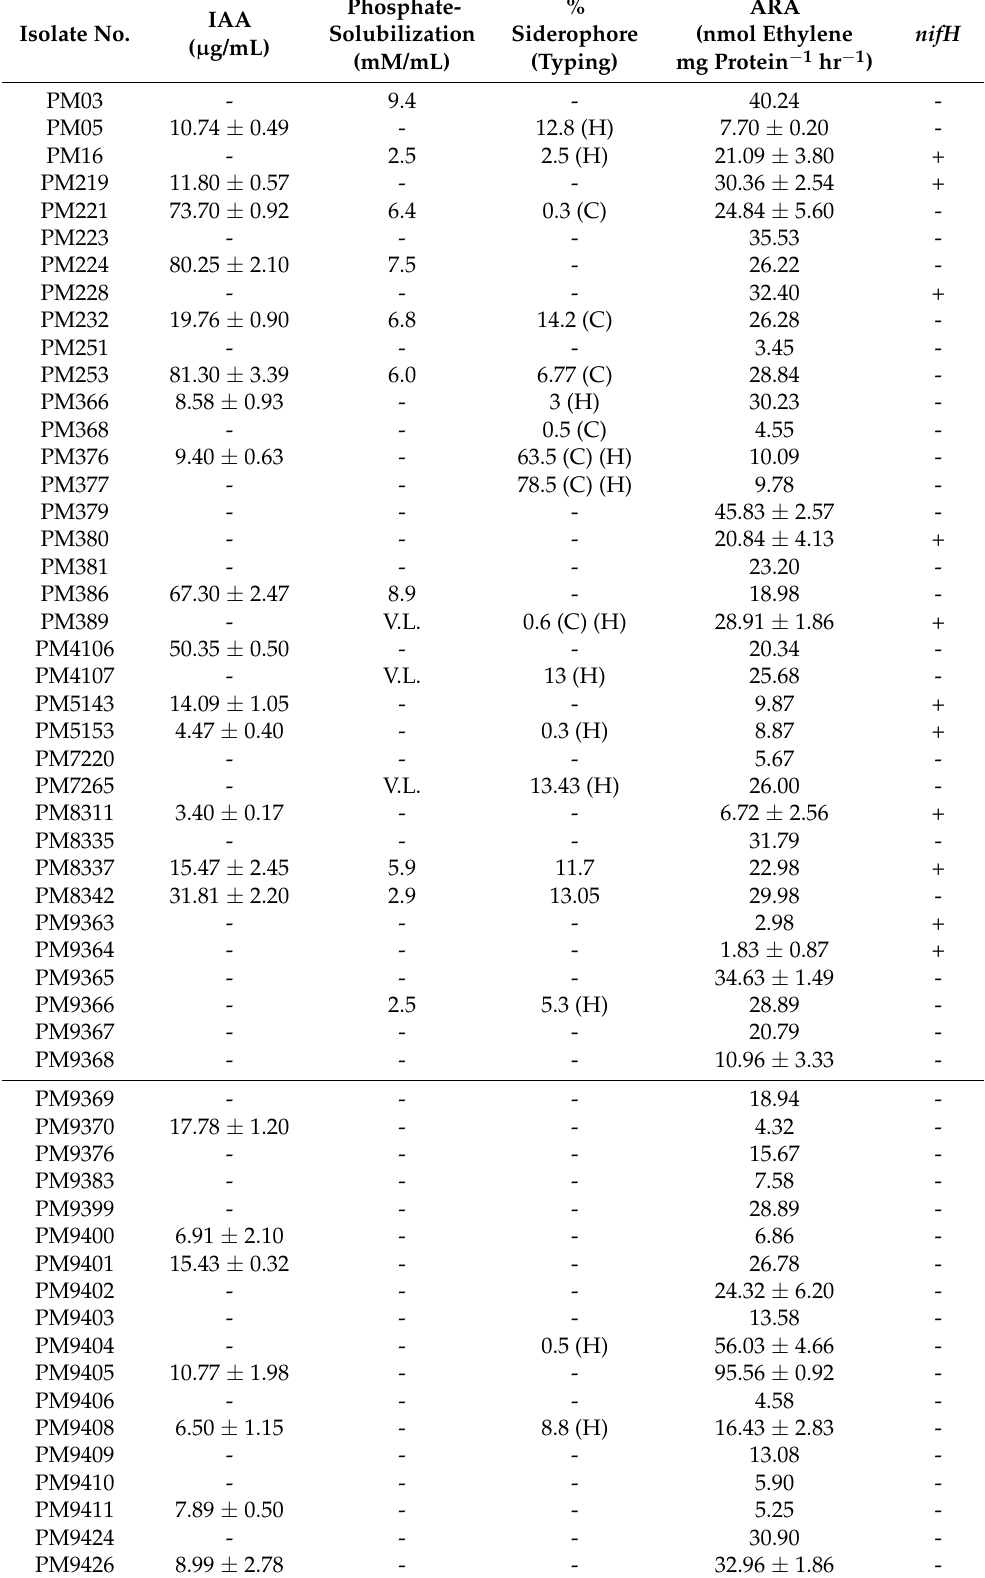
Table 2. Plant growth promoting traits of various strains obtained in this study.